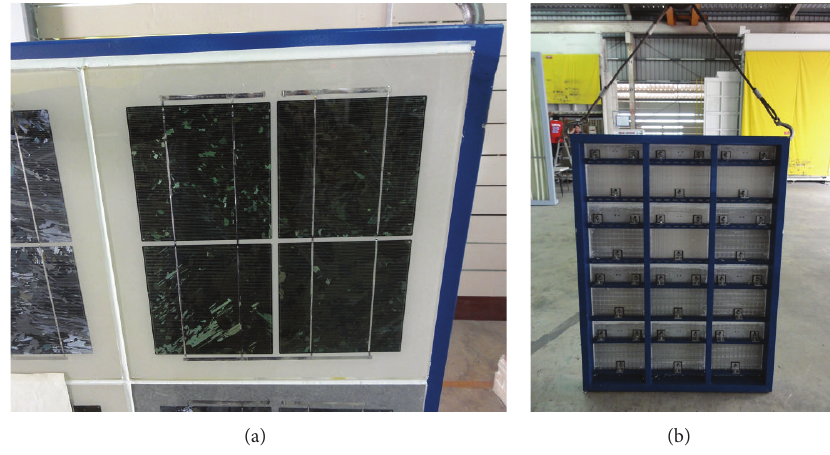
Figure 2: (a) Outward and (b) backward sides of the PV module.